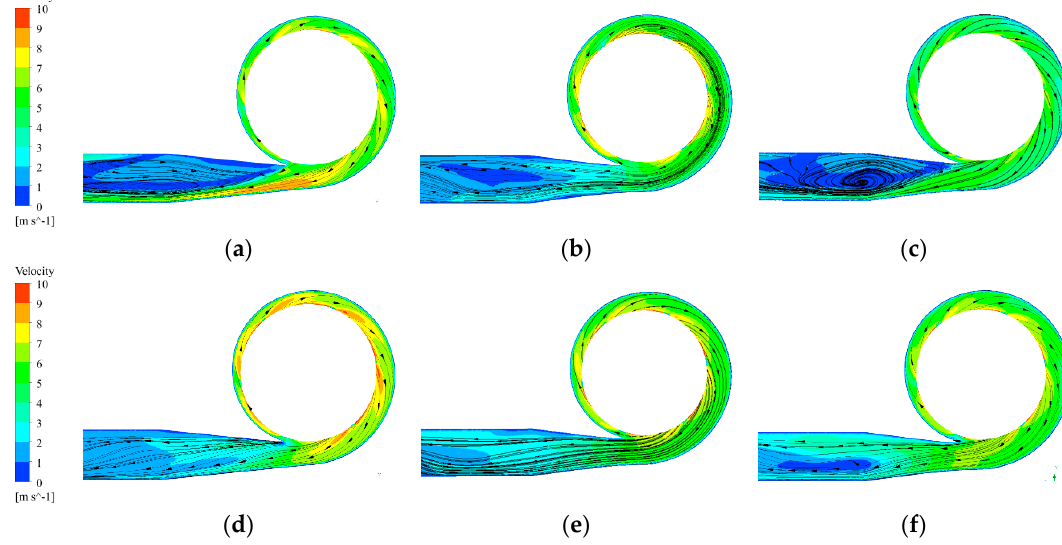
Figure 14. Comparison of velocity streamline in volute for the two schemes: ( a ) origin, 0.8 Q d ; ( b ) origin,